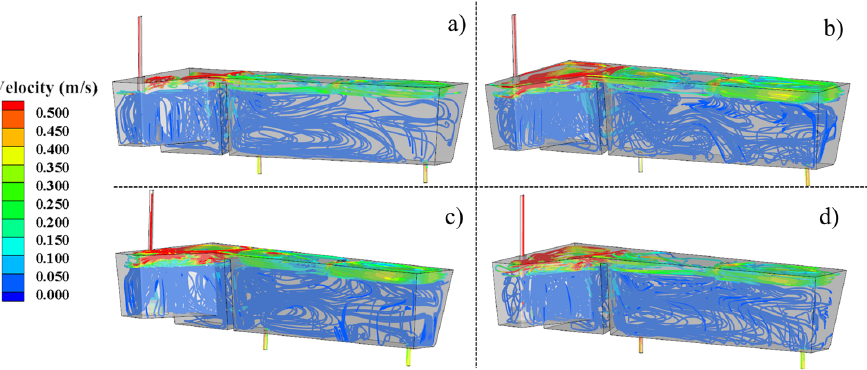
Figure 4. Flow fields with different heating powers. ( a ) Without plasma heating, ( b ) 300 kW, ( c ) 500 kW and ( d ) 1000 kW.